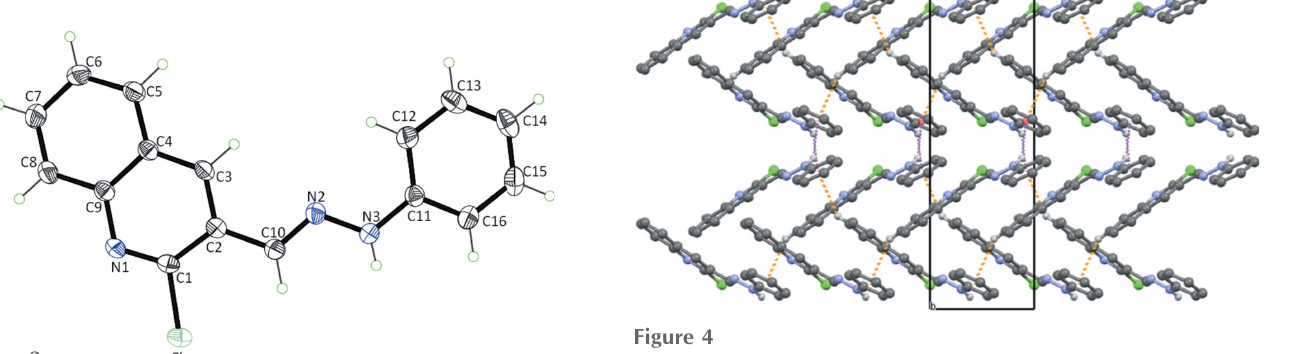
Figure 2 The molecular structure of compound 5 with the atom labelling. Displacement ellipsoids are drawn at the 30% probability level.